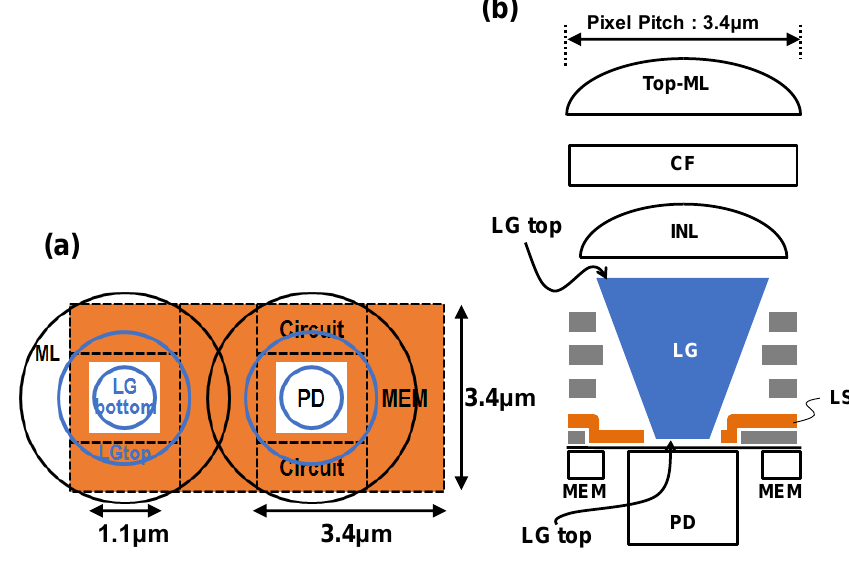
Figure 7. ( a ) Top-view and ( b ) the cross-section diagram of the pixel.